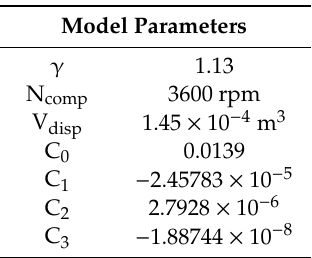
Table 1. Model parameters.